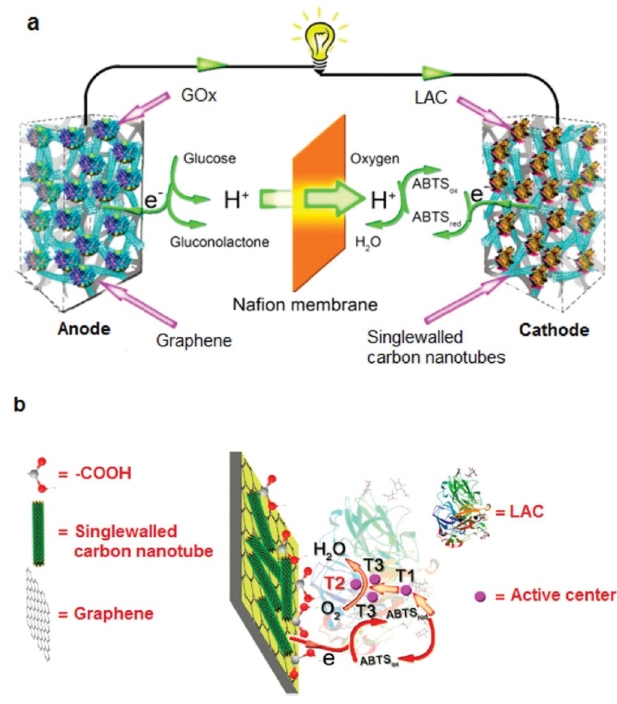
Fig. 9. (a) Illustration of the enzymatic biofuel cell equipped with 3-dimansion graphene-single-walled carbon nanotube hybrid electrodes; (b) Illustration of electron transfer pathways